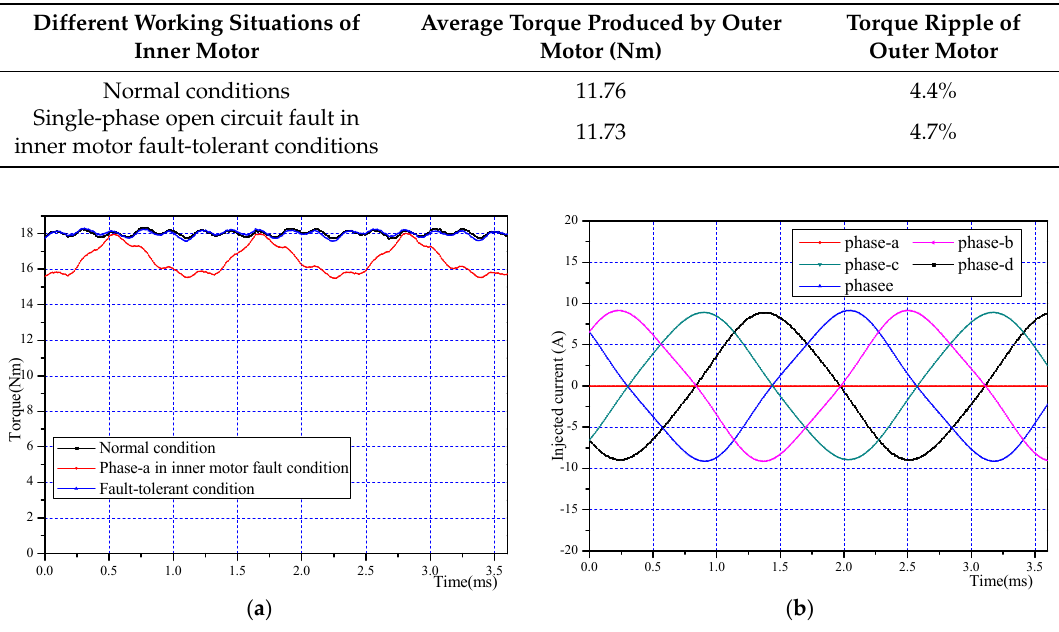
Time(ms) Normal condition Single-phase open-circuit fault-tolerant in inner motor condition Figure 16. Torque waveform of outer motor when inner motor is working under different conditions. 3.1.3. Single ‐ Phase Open ‐ Circuit in Both Inner Motor and Outer Motor The open ‐ circuit fault ‐ tolerance of different phases in the inner motor (or in outer motor) leads to different torque ripple characteristics. On the other hand, the total torque is a superposition of inner motor torque and outer motor torque. So, when torque of the inner motor and outer motor with different torque ripple characteristics is superposed, the torque ripples are different in terms of produced torque. So, for this fault type, there are three different fault cases: the same phase in inner motor and out motor are open open ‐ circuit phases (Figure 17a: assume phase “a” in outer motor and in inner motor are open phases); “adjacent phase” in inner motor and out motor are open open ‐ circuit phases (Figure 17b: assume phase “a” in outer motor and phase b in inner motor are open phases); “non ‐ adjacent phase” in inner motor and out motor are open open ‐ circuit phases (Figure17c: assume phase “a” in outer motor and phase “c” in inner motor are open phases). For three fault cases of this type, the torques obtained by FEA are shown in Figure 18a). The injected currents are a combination of the above two fault types (Sections 3.1.1 & 3.2.2). The torque details of these three fault cases are shown in Table 10. From Figure 18a and Table 10, it can be seen the average torque of these three fault situations is almost equal while the differences in torque ripples are larger. Figure 18b shows the torque waveform by the inner motor and outer motor, respectively, under different fault cases of this fault type. The torque ripple is smaller under fault case b and case c, and this is because the torque ‐ ripple produced by the inner motor and outer motor has the effect of offsetting each other as seen from Figure 18b.